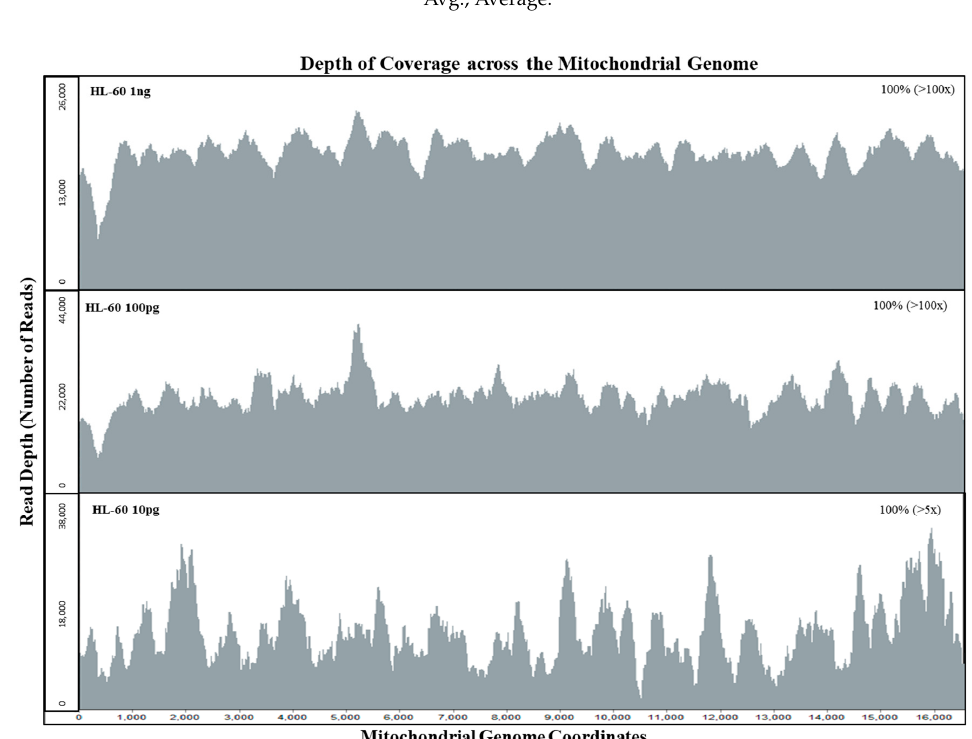
Figure 2. Depth of coverage across the whole mitochondrial genome for mtDNA sensitivity study samples. Limiting dilution of HL60 control DNA samples were tested with input DNA amounts of 1 ng, 100 pg, and 10 pg for the mtDNA sensitivity study. All HL60 samples exhibited full coverage